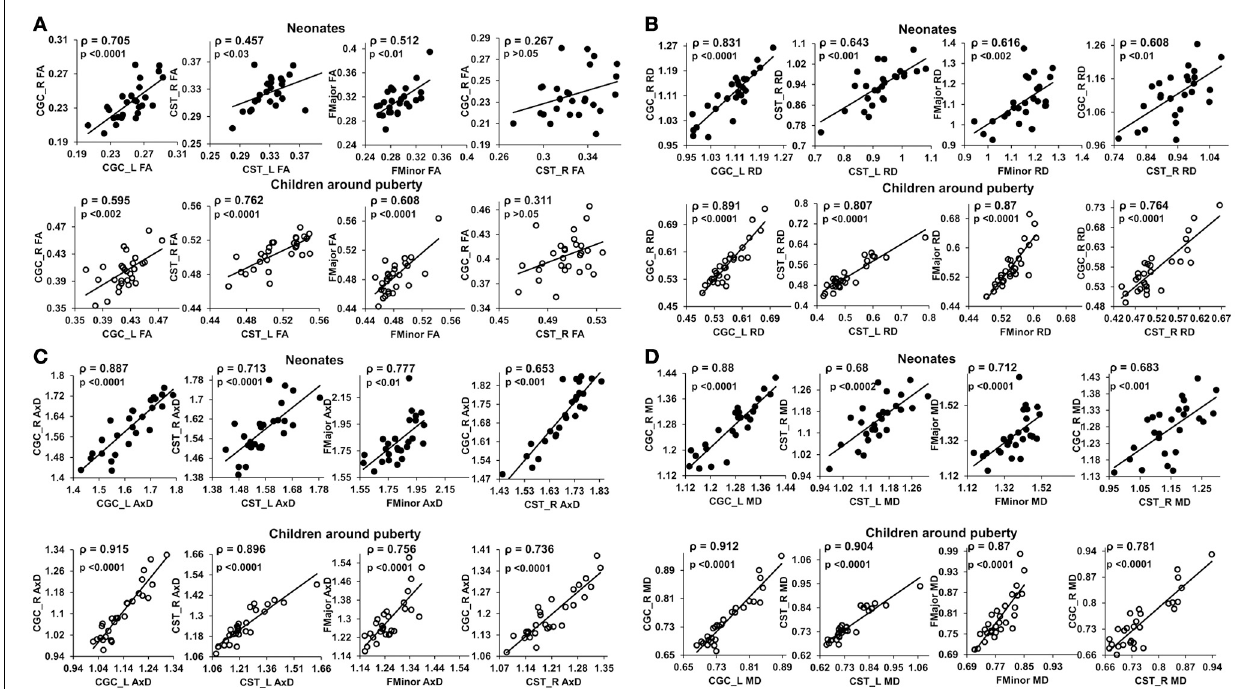
FIGURE 3 | Scatterplots of FA (A), RD (B), AxD (C) and MD (D) values from 2 homologous and 2 non-homologous tracts. The 2 homologous pairs and FMajor/FMinor represent tract pairs of three tract groups for both age groups. Top panel shows the inter-tract scatter plots for the neonates and